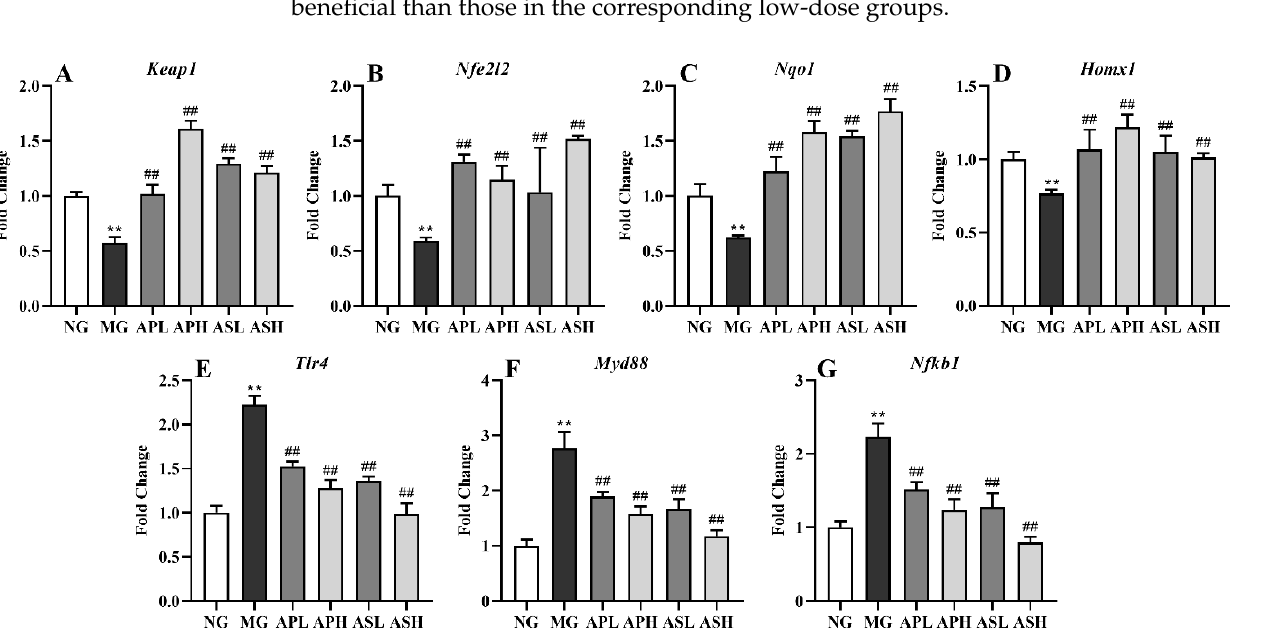
Figure 6. Effect of AP and AS on oxidative stress and inflammation-related gene expression in ALD mice. ( A ) Keap1 ; ( B ) Nfe2l2 ; ( C ) Nqo1 ; ( D ) Homx1 ; ( E ) Tlr4 ; ( F ) Myd88 ; ( G ) Nfkb1 . Data are expressed as mean ± SD ( n = 12). ** p < 0.01, vs. NG; ## p < 0.01, vs. MG.